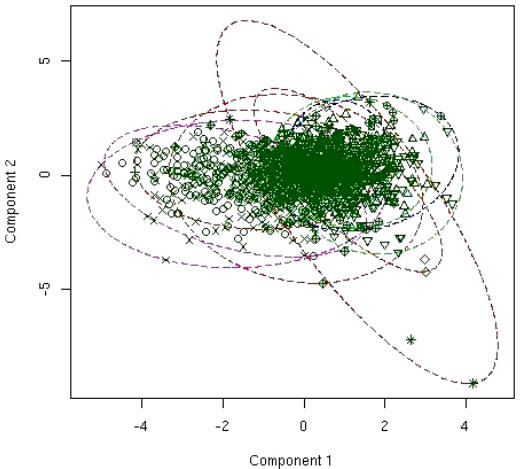
Fig. 2. Reallocated 1484 Data by KFCM.